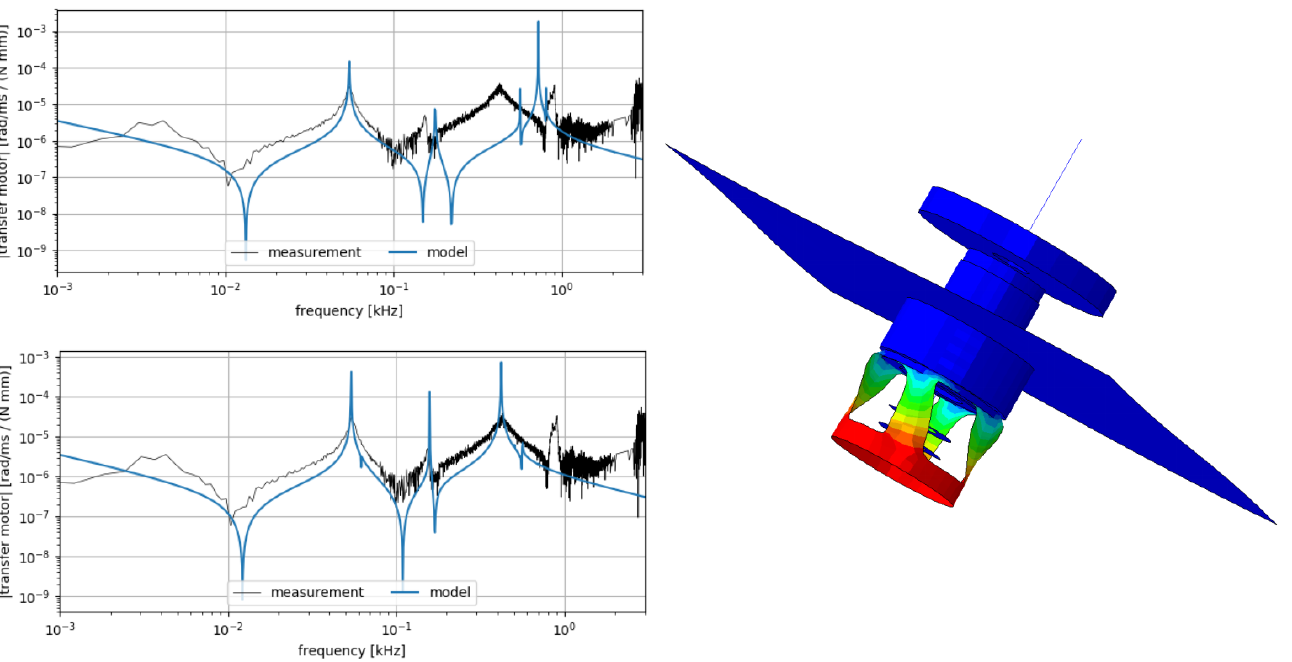
Figure 17. Example of FEM model geometry/stiffness modification: adjustment of the flexible shaft structure and stiffness allowed to improve model fidelity, left plot-amplitude FRF comparison prior to modifications ( top ) and after the proposed adjustments ( bottom